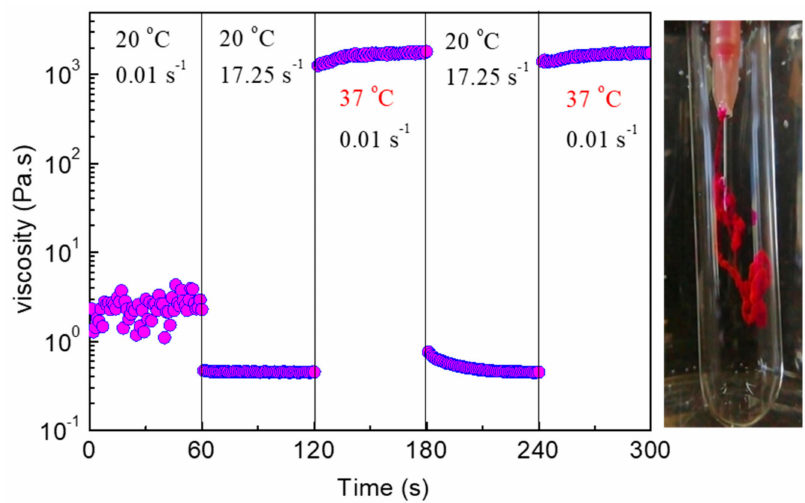
Figure 10. Shear viscosity versus time of a 4 wt % NaALG- g -P(NIPAM 80 - co -NtBAM 20 )/DMEM formulation subjected to consecutive variations of shear rate and/or temperature, as indicated, in time intervals of 60 s. The digital photo ( right ) shows injection of the formulation through a 28 g needle in water, regulated at 37 ◦ C.